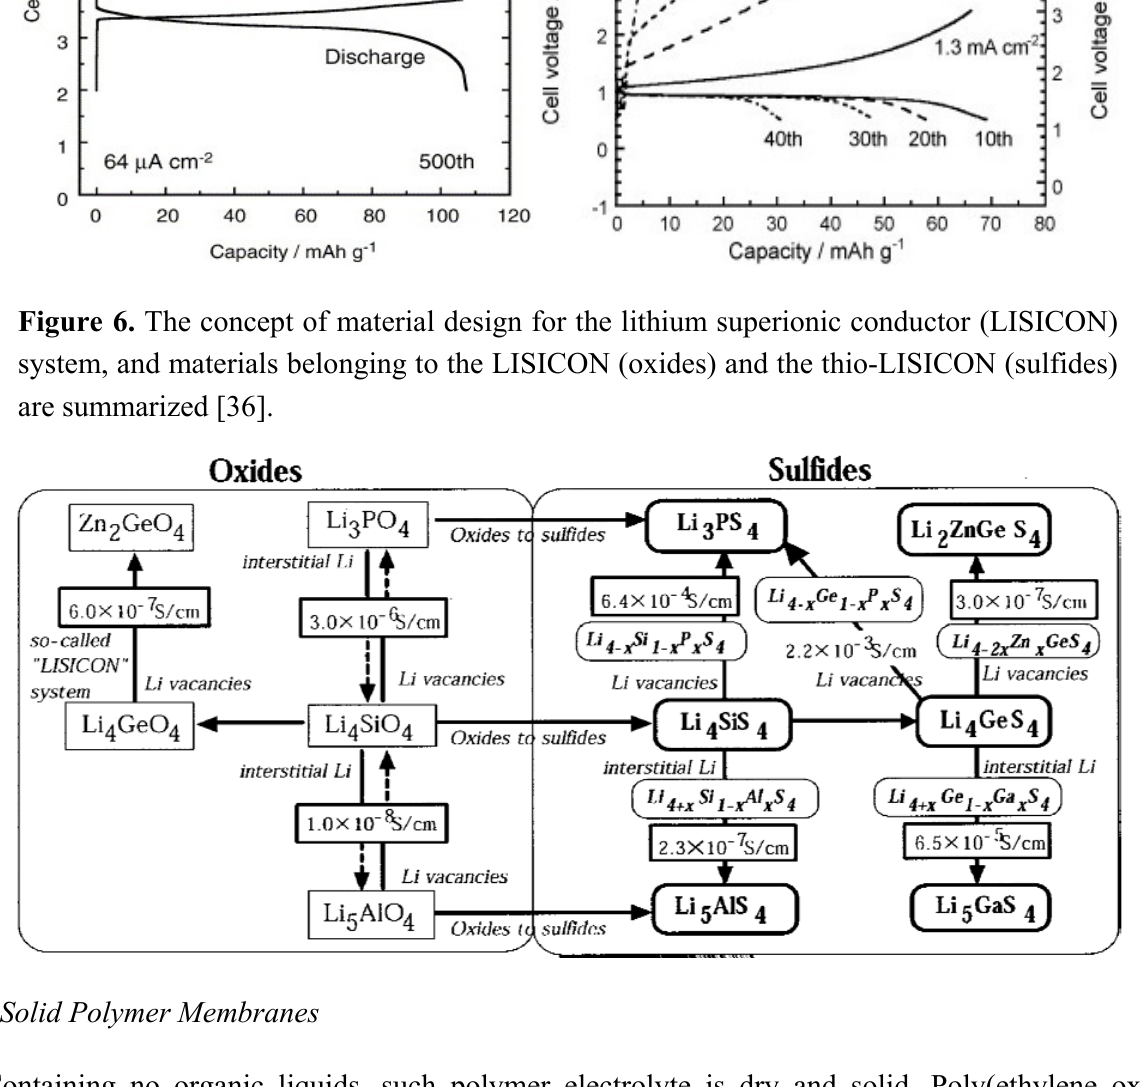
S-27P S -3P O /Li Ti O 2 2 5 2 5 4 5 12